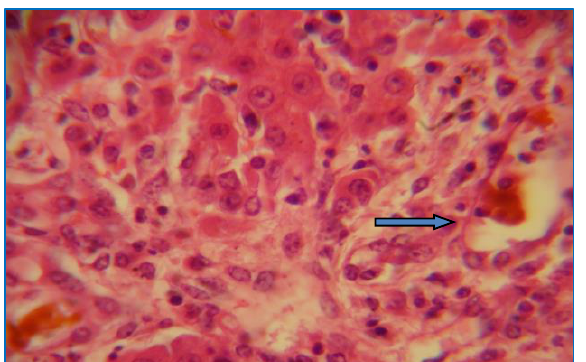
Figure, 8: G4:-Liver of rabbit at 10 days post infection show increase in the numbers of binucleated hepatocytes ( ) (H and E 40X).